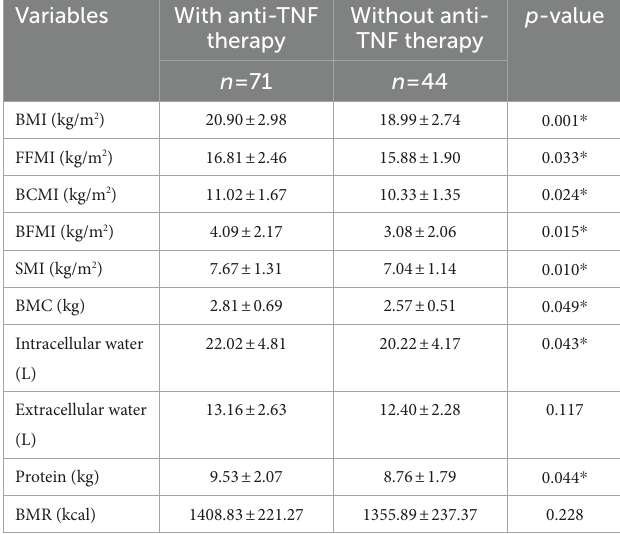
TABLE 2 Comparison of body composition measured by bioelectrical impedance analysis. Variables With anti-TNF